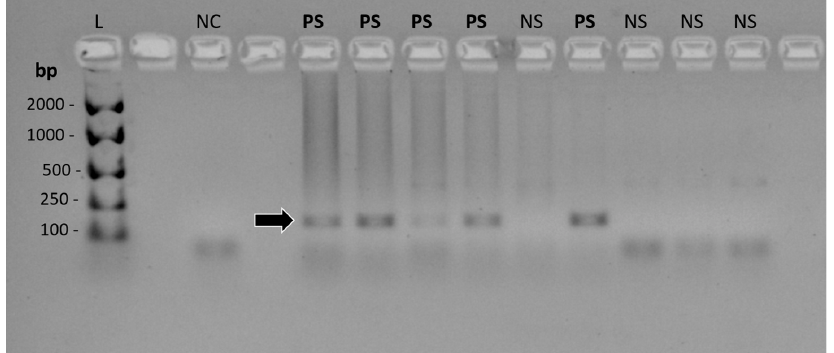
Figure 3. Conventional PCR for FcaGHV1. Agarose gel visualised under UV light, contrast inverted. The 164 bp product is identified by an arrow. Abbreviations: bp, base pair fragment length; L,